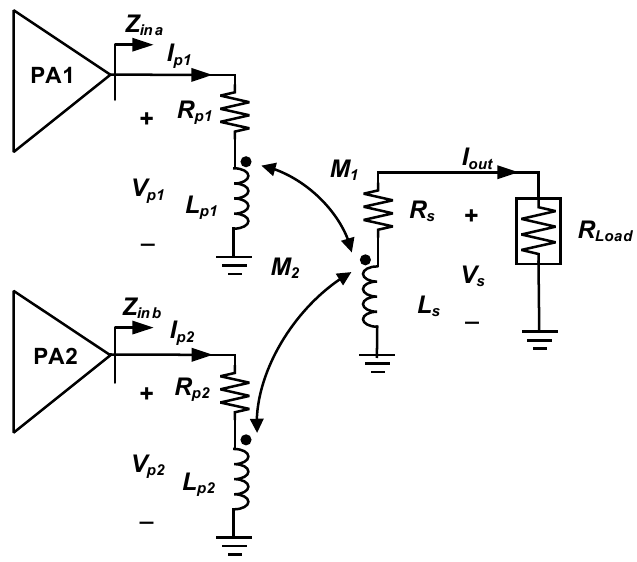
Figure 1. Equivalent non-ideal circuit model of a parallel power-combining transformer.